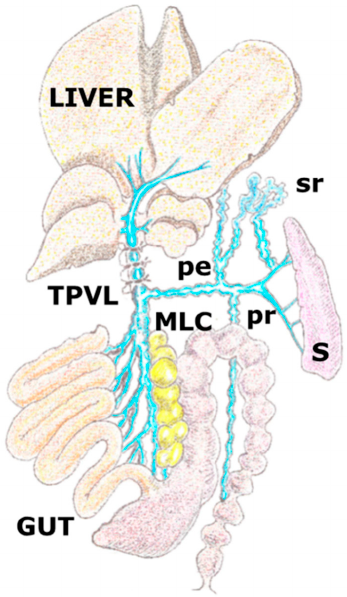
Figure 1. Graphic representation of the porto-systemic collateral circulation in the rat after performing a partial portal vein ligation. The triple partial portal vein (TPVL) ligation technique has been used to increase resistance of venous portal flow and subsequently, the portal hypertension degree and therefore the related splanchnic inflammatory response. Collateral circulation with paraoesophageal (pe), splenorenal (sr) and pararectal (p) vessels. MLC: mesenteric lymphatic complex; S: